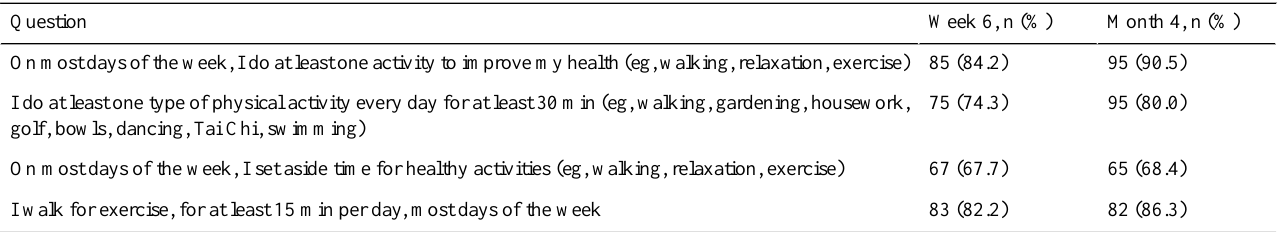
Table 4. Percentage of “agree” and “strongly agree” responses to questions in the health-directed behavior component of the Health Education Impact Questionnaire in the intervention